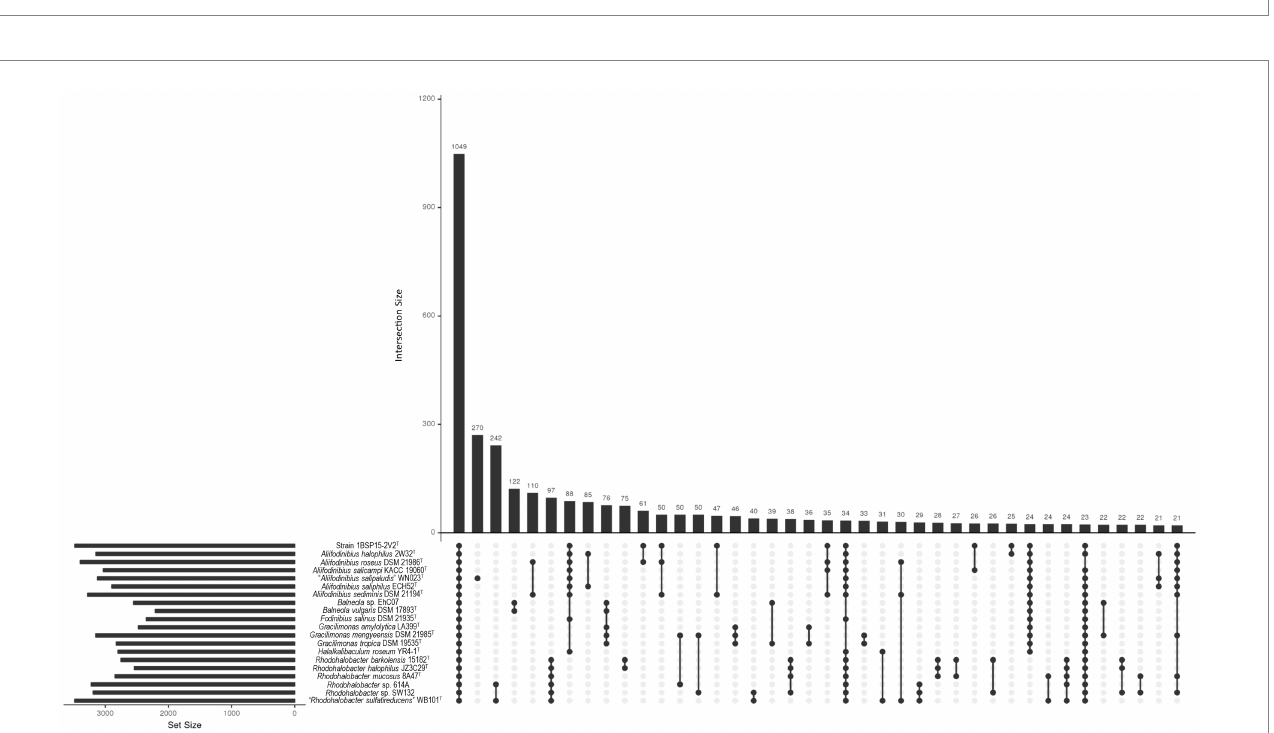
FIGURE 5 OrthoANI (upper triangle) and GGDC (lower triangle) matrix among the 20 studied genomes of the family Balneolaceae . All GGDC (purple) and orthoANI (green) values were below the cutoff for species delineation, indicating that all the genomes belong to different species.